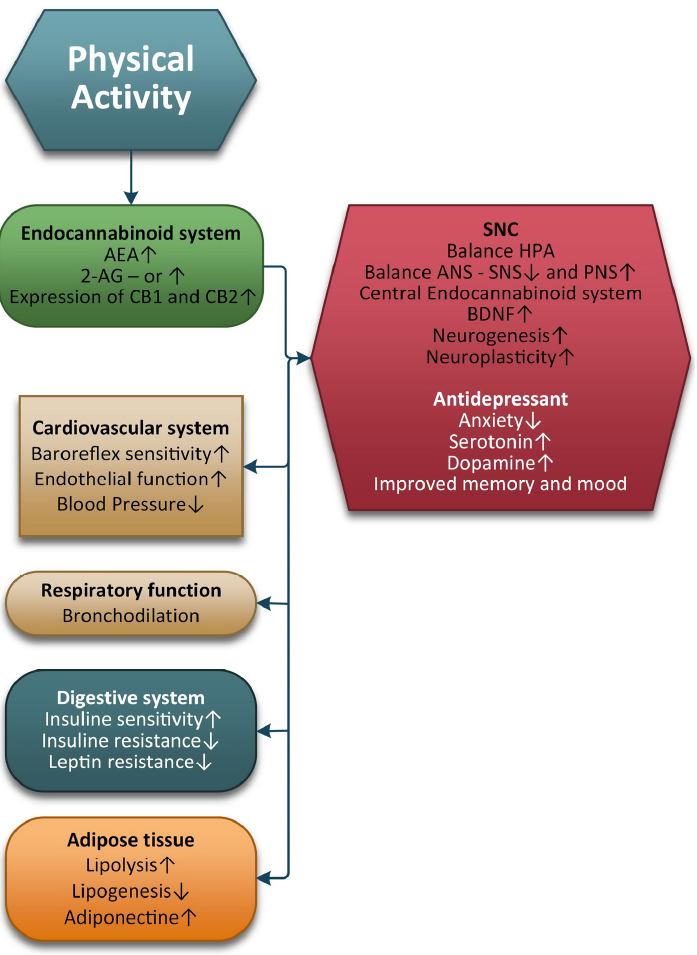
Figure 3. Basic changes in the endocannabinoids in multiple organs in response to physical exercise.